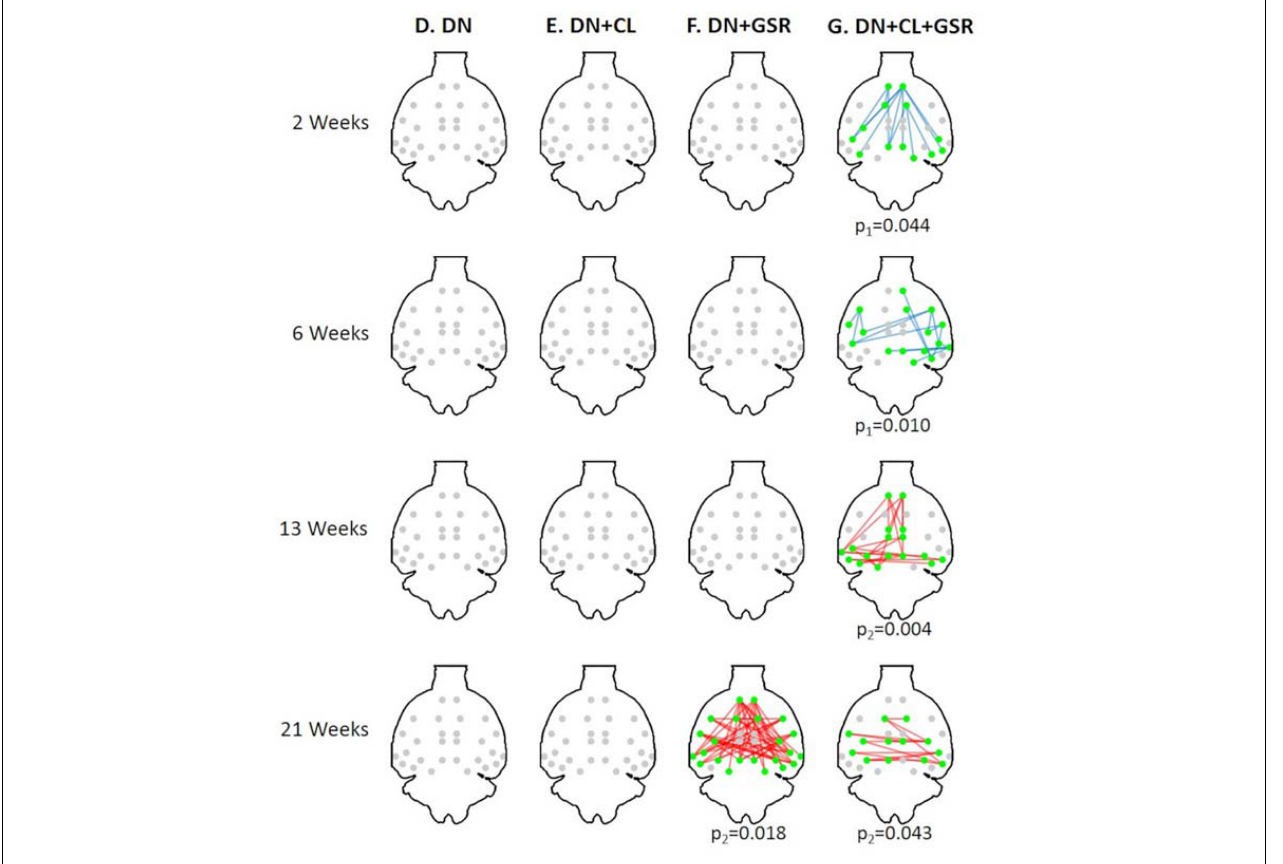
FIGURE 12 | Significant differences in FC between the CTL and STZ groups of pooled Cohorts 1 + 2 at each timepoint (2, 6, 13, and 21 weeks) for data processing approaches (D–G) under NBS threshold 2.2. No significant difference was found with pipelines (D–F) (except pipeline F at 21 weeks). In particular, previous widespread differences at 6 weeks with pipelines (E,F) from Cohort 1 ( Figure 8 ) disappeared entirely for Cohorts 1 + 2. Pipeline (G) exhibited similar group differences to previously ( Figure 8 ) with the exception of new significant edges at 21 weeks, given a large increase in number of datasets at 21 weeks with the addition of Cohort 2. Blue edges indicate group differences in contrast 1 ( STZ > CTL ), and red edges indicate group differences in contrast 2 ( STZ < CTL ). p 1 and p 2 are FWER corrected p -values for contrast 1 and contrast 2, respectively. Green nodes indicate ROIs involved in group